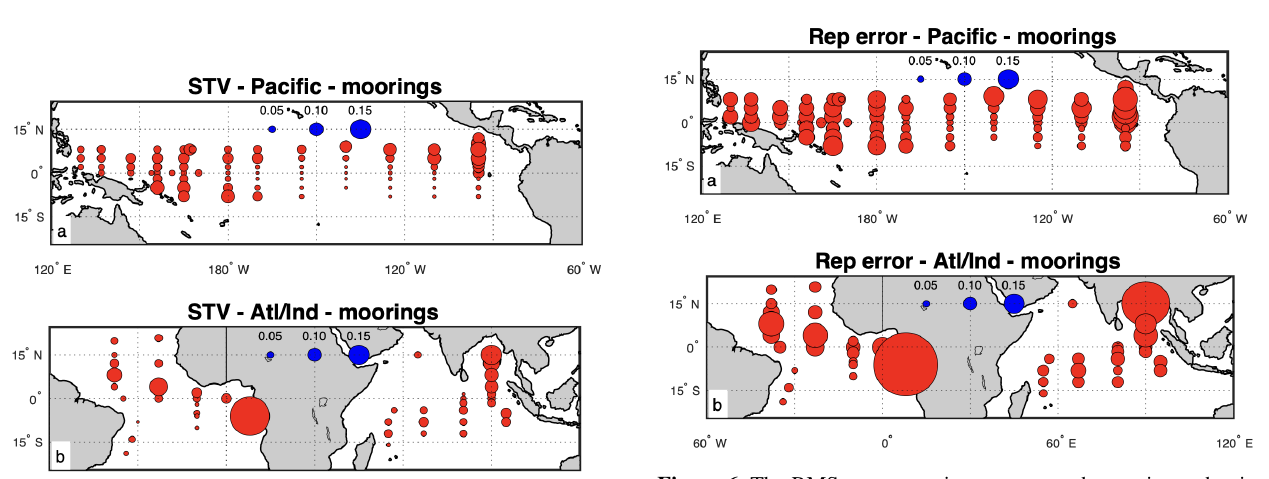
Figure 6. The RMS representation error at each mooring – that is, the RMS difference between random samples and short-term mean values. Panel (a) shows the Pacific Basin, and panel (b) shows the Atlantic and Indian basins. The sizes of the circles indicate the mag- nitude of the RE, with the scale shown as blue circles near the mid- dle of each panel.